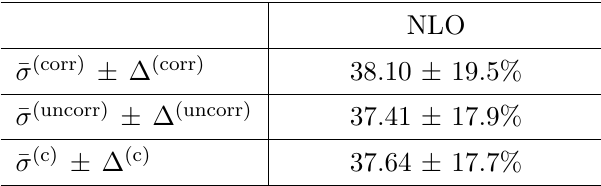
Table 3 . The central value and the total theoretical uncertainty for the Higgs production cross √ section by gluon fusion at NLO for s = 13 TeV. The settings are indicated in the text. All results are produced with NLO PDFs, and the central values and total theoretical uncertainty are computed according to three different prescriptions. ∆ (corr) is the correlated theoretical uncertainty in which the scale variation in the PDF fit are correlated with the scale variations in the computation of the partonic cross section, eqs. (4.5) and (4.6). ∆ (uncorr) is the theoretical uncertainty in which the scale variations in the PDF fit are uncorrelated with the scale variations in the computation of the partonic cross section, eqs. (4.16) and (4.18). ∆ (c) is the total theory uncertainty in which scale uncertainty is included only in the partonic cross section, eqs. (4.13) and (4.14). The NNLO central value is 46 . 53